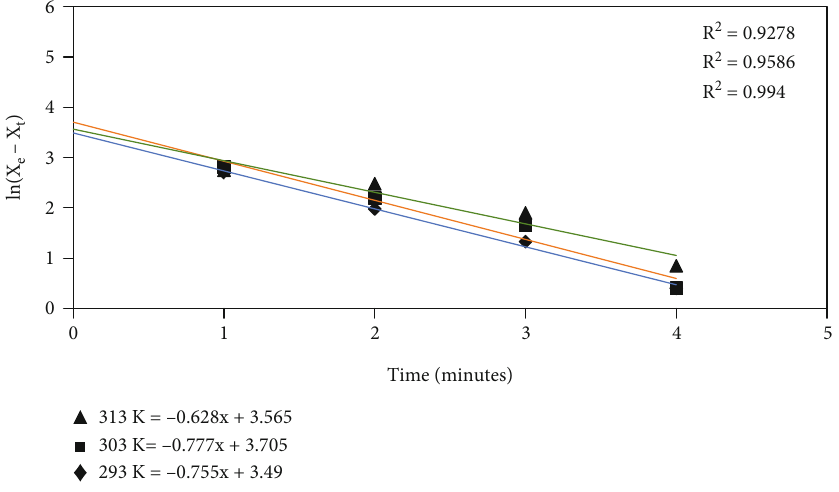
Figure 9: Pseudo- fi rst-order kinetic plot of M.B onto BTW. Table 2: Constant of pseudo- fi rst-order kinetics.